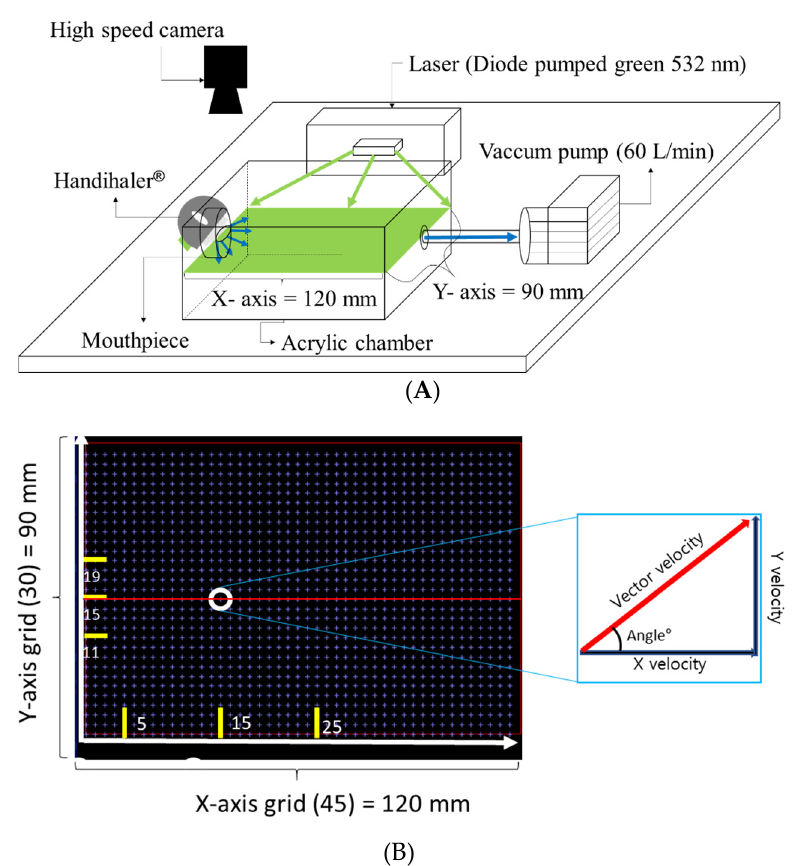
Figure 1. ( A ) Schematic diagram of PIV system; and ( B ) grid design and vector analysis point (15, 15).